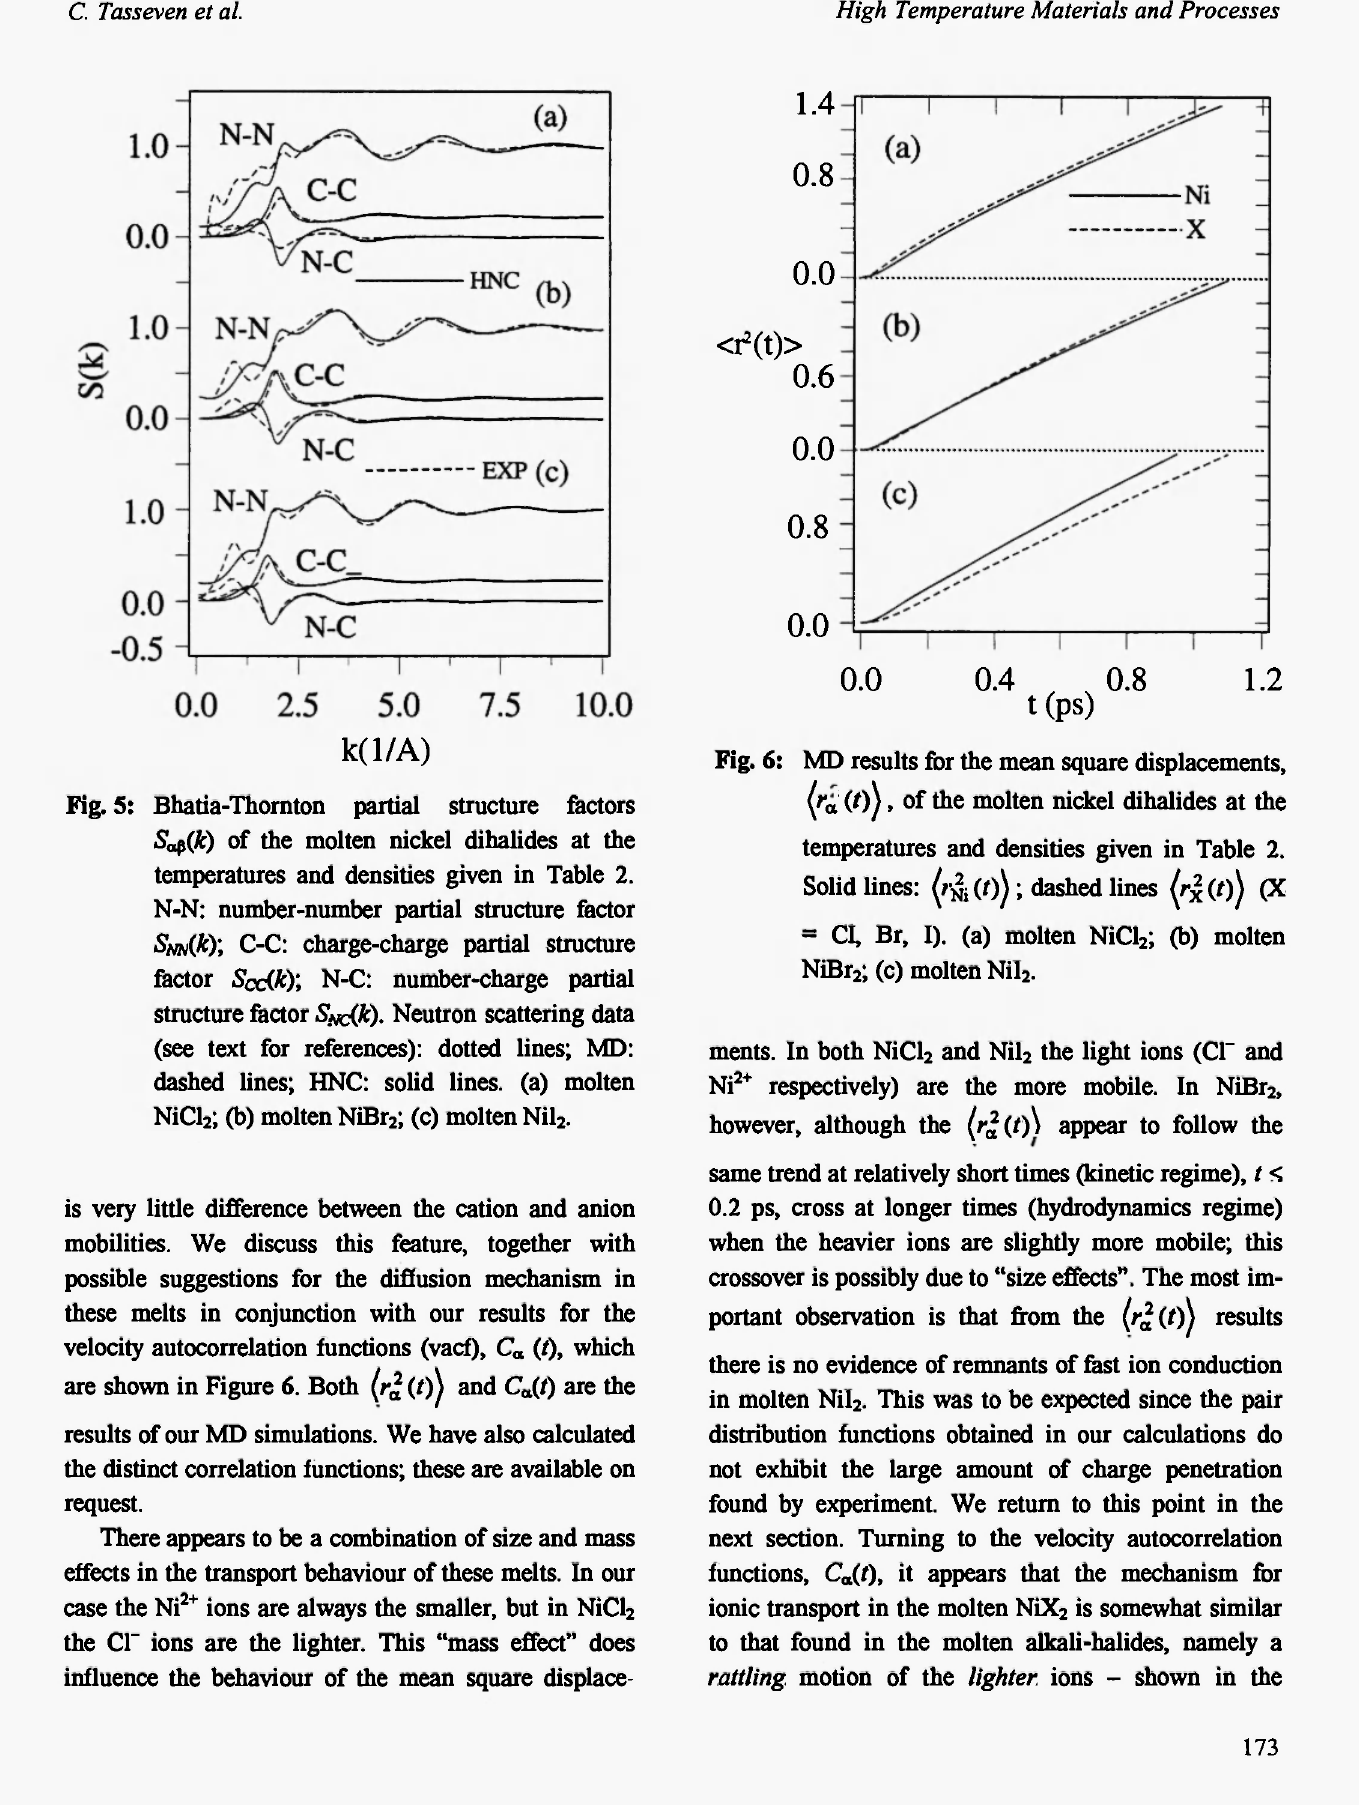
Fig. 5: Bhatia-Thornton partial structure factors Sap(k) of the molten nickel dihalides at the temperatures and densities given in Table 2.